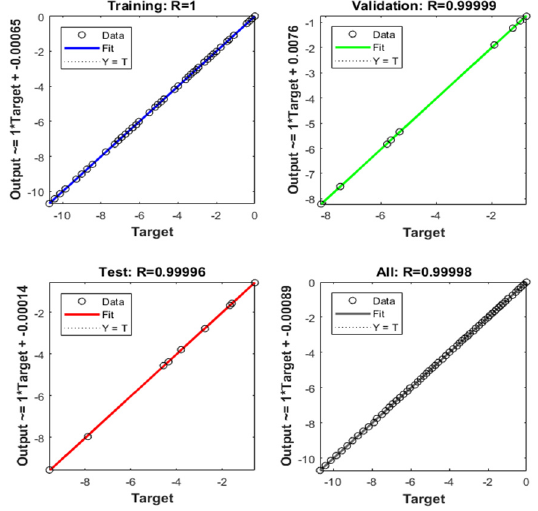
Figure 13. The correlation value of laboratory data and the ANN method (BRC-4 beam).